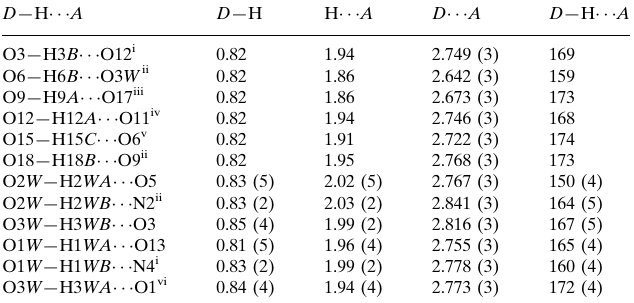
Hydrogen-bond geometry (A˚ , (cid:3) ). D —H (cid:2)(cid:2)(cid:2)